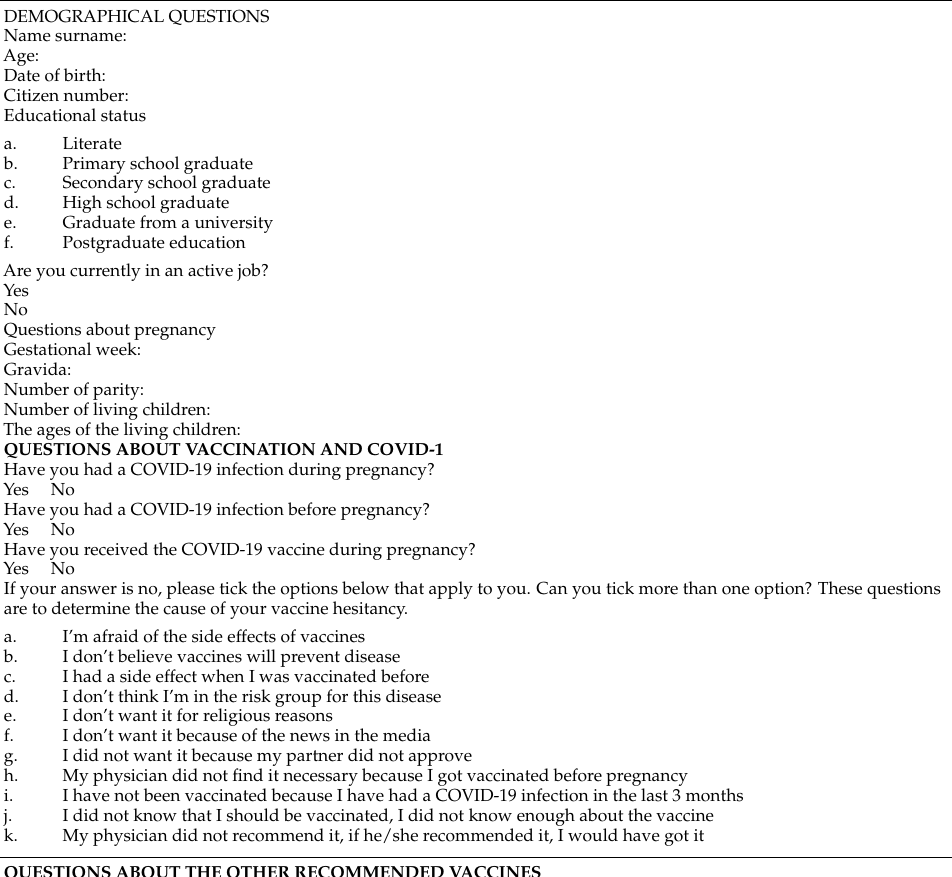
Table 1. Questionnaire